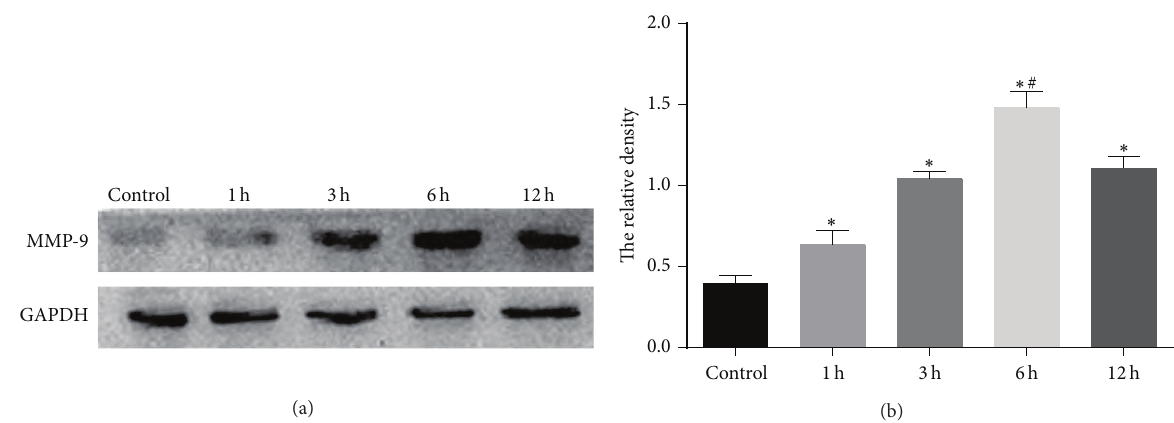
Figure 4: Scratch-injured human umbilical vein endothelial cells (HUVECs) supernatants induced MMP-9 expression in THP-1 cells. (a) MMP-9 protein expression in control cultures and in cultures treated with the supernatants of scratch-injured HUVECs for 1, 3, 6, and 12h. (b) Quantitative data for (a). ∗ 𝑃 < 0.05 compared with control; # 𝑃 < 0 . 05 compared with rest